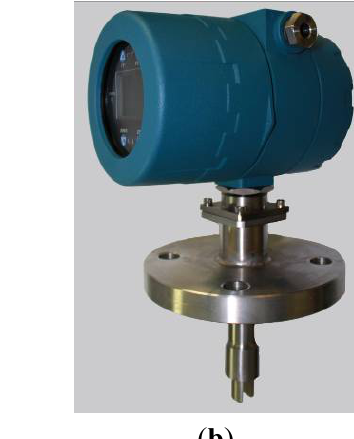
Figure 8. ( a ) Digital closed-loop control system; ( b ) Theoretical